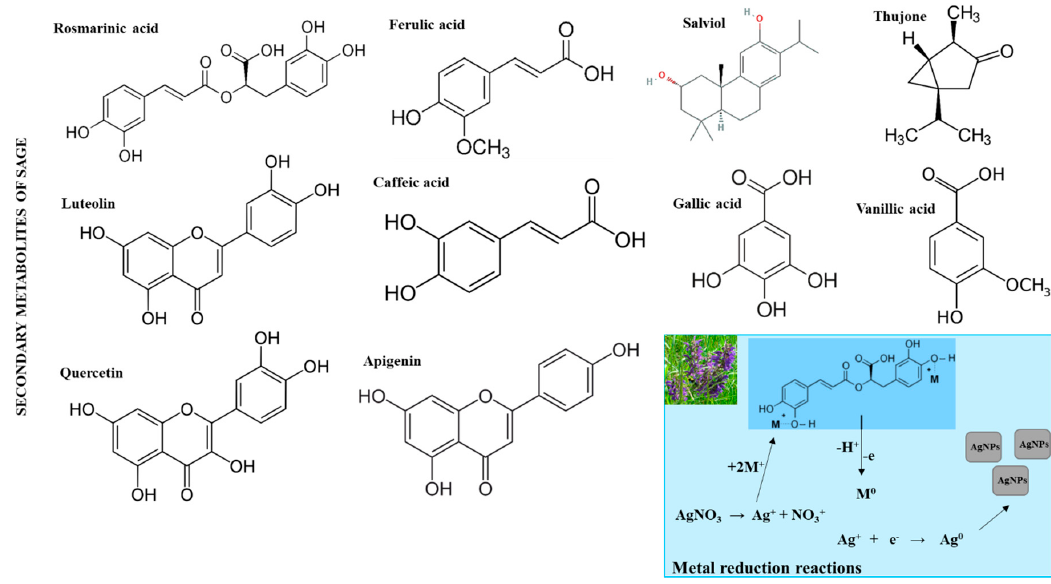
Figure 2. Biologically important secondary metabolites found in Salvia officinalis at high concentrations. Antibacterially active molecules such as salviol and thujone have been identified. In inset: A proposed scheme for reduction of silver ions in the presence of phenolic compounds is also shown. The resulting reduced ions subsequently form aggregates in the form of nanoparticles.